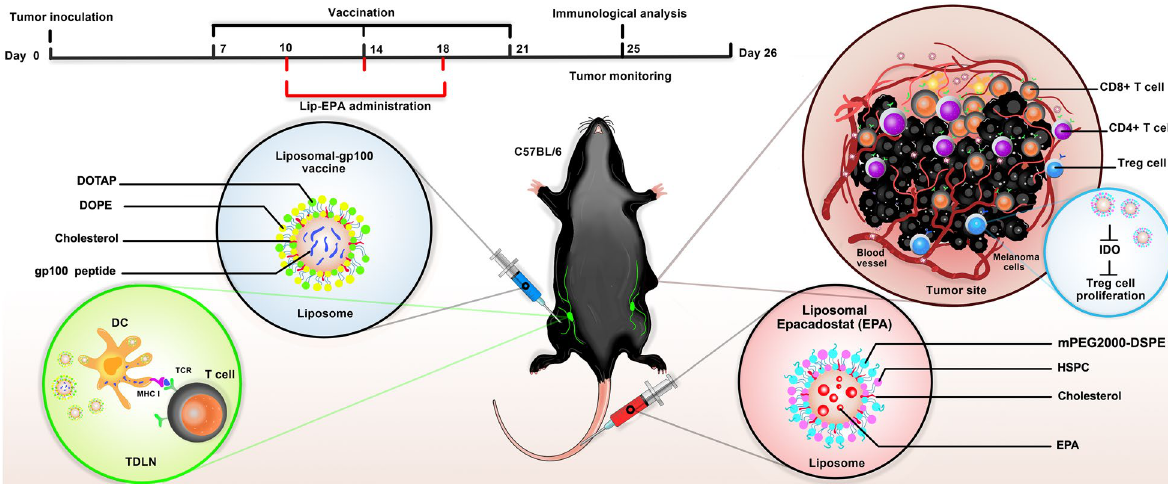
Figure 1. Schematic illustrations of liposomal gp100 formulation used as a therapeutic vaccine in combination with liposomal Epacadostat as an IDO inhibitor in B16F10 melanoma mouse